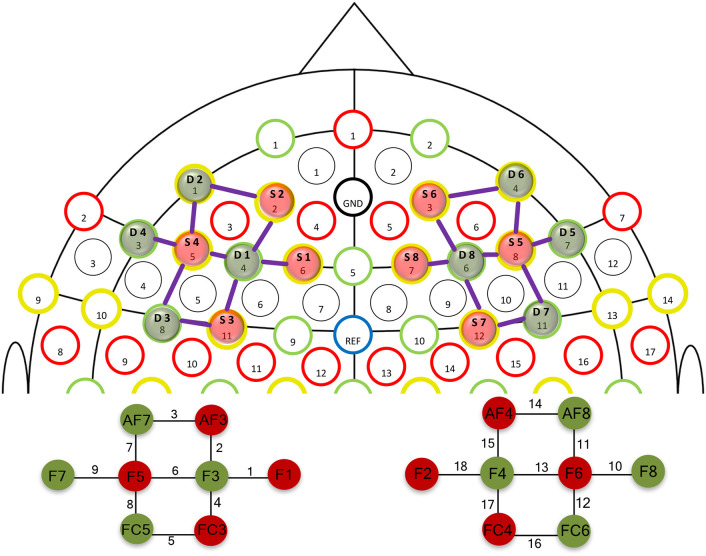
fNIRS optode setup for the left and right dlPFC according to the 10–20 system (Zimeo et al., 2018a).